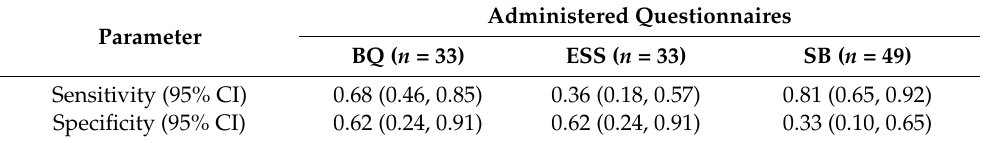
Table 2. Questionnaire Test Parameters for Administered Questionnaires. Comparison of the sensitivity and specificity of BQ, ESS, and SB with 95% CI for the outcome of at least mild sleep disordered breathing (AHI ≥ 5).